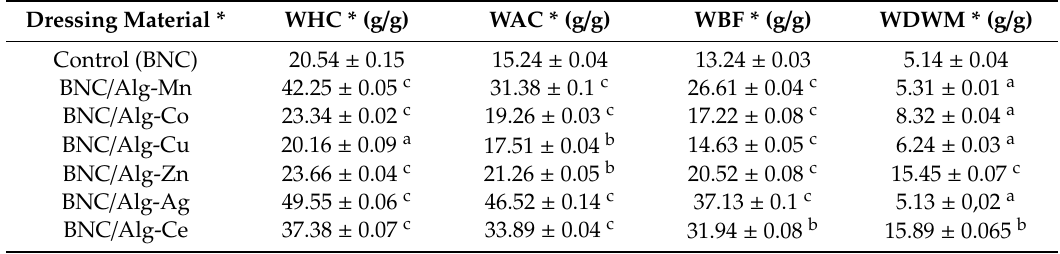
Table 1. Water holding capacity and adsorption behavior of cation cross-linked Alg / BNC composites. Dressing Material